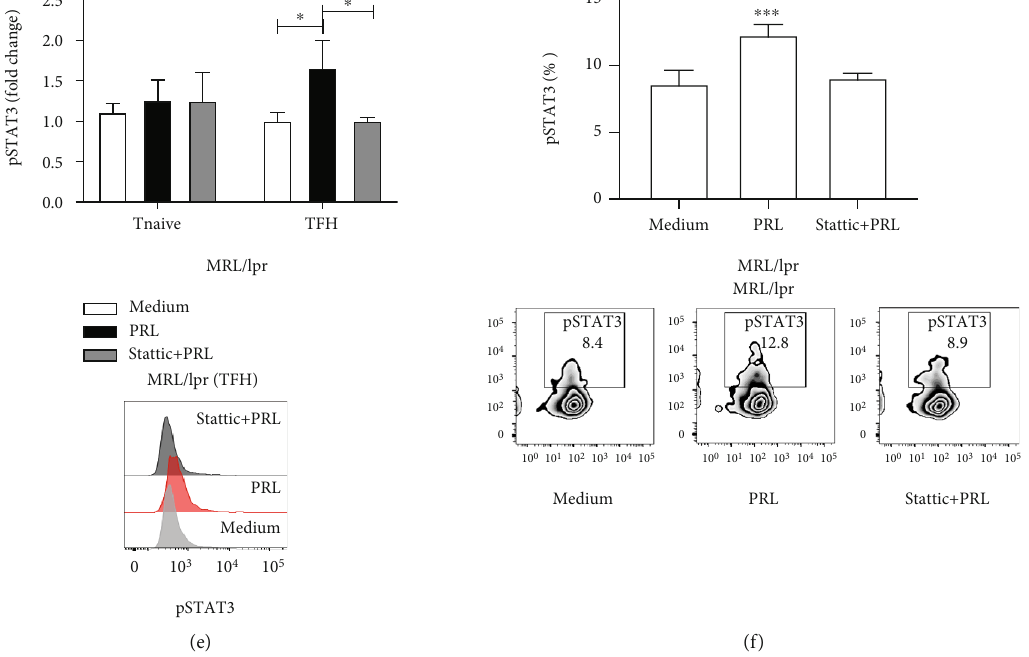
Figure 5: Activation and signaling of di ff erentiated T cells in vitro in the presence of PRL. T cells from 9-week-old C57BL/6 and FH naïve MRL/lpr mice were puri fi ed by MACS and di ff erentiated to T with or without PRL. (a) Expression of OX40 (MFI) and representative FH histograms of OX40 expression in T cells from MRL/lpr mice. (b) Percentage and representative Zebra plots of T OX40 + cells. (c) FH FH Expression of IL21 (MFI) and representative histogram of IL21 expression in T cells from MRL/lpr mice. (d) Percentage and Zebra FH IL21 + cells. (e, f) T and T cells were preincubated for 30 min with the inhibitor of STAT3 (Stattic). For STAT3 plots of T FH naïve FH inhibition, T cells were di ff erentiated to T , left to rest for 8 h, and then incubated for 30 min with PRL to subsequently determine naïve FH the MFI of pSTAT3 (histogram). For the plot, pSTAT3 is reported as fold change taken as baseline levels found in T or T cells only naïve FH treated with medium. (f) Percentage and Zebra plots of pSTAT3. Six di ff erent experiments were performed; each experiment was done in duplicate. Pooled data are presented as the mean ± SD ; ∗∗∗ p < 0 : 0001 and ∗ p < 0 : 05 using